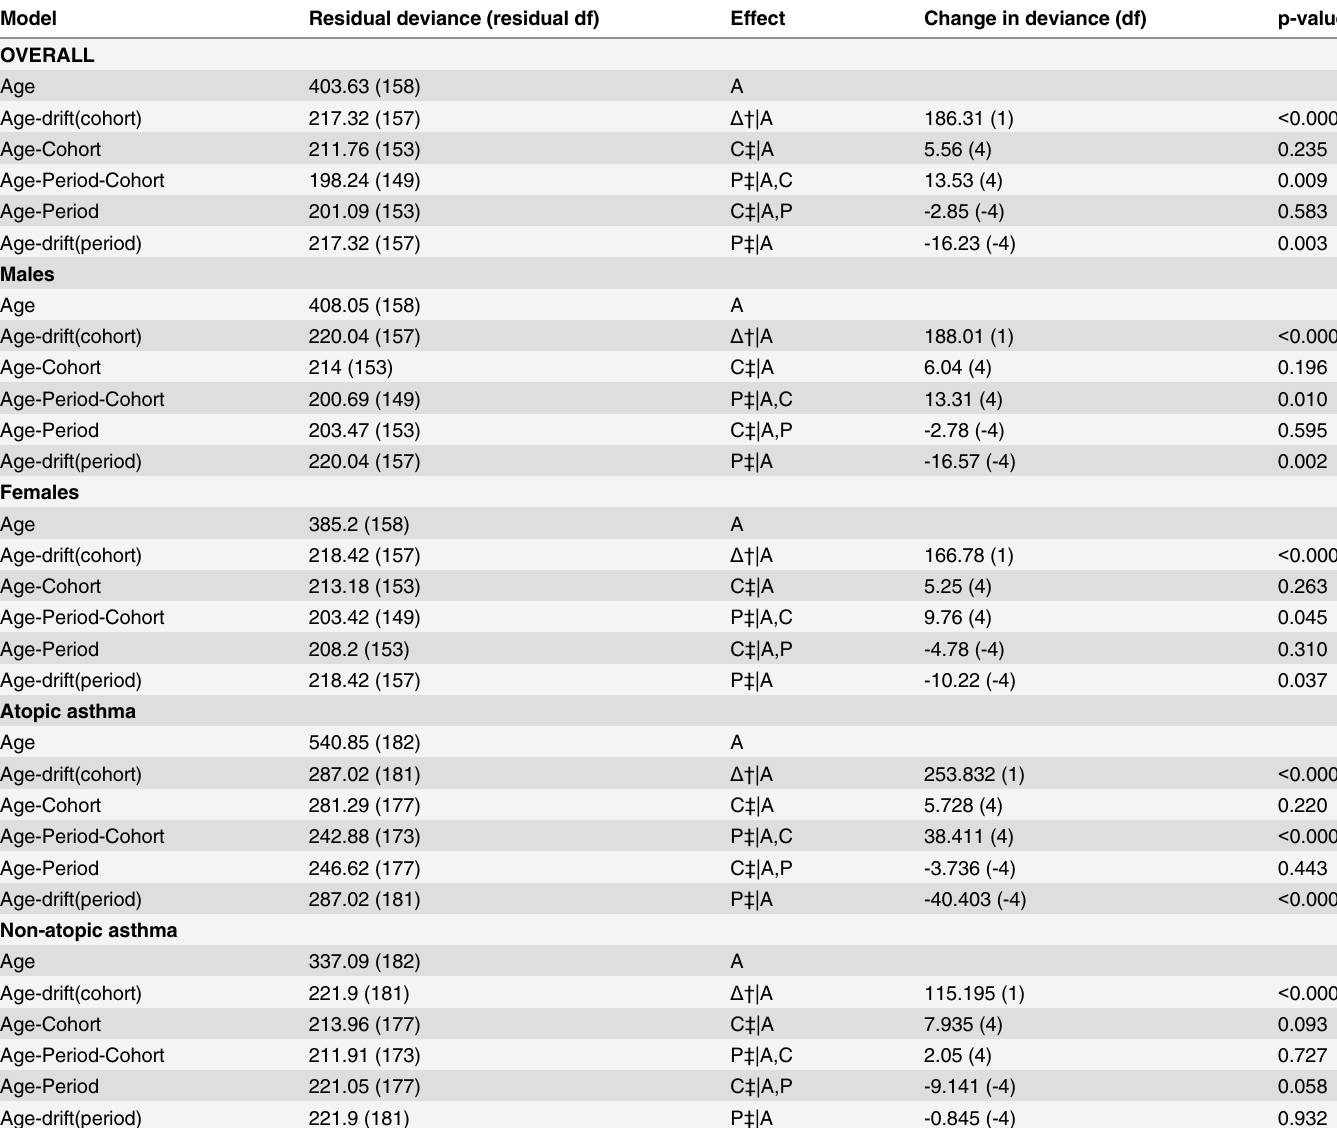
Table 2. Comparison of age-period color sub-models for asthma rates in males and females and for atopic and non-atopic asthma in Italy.